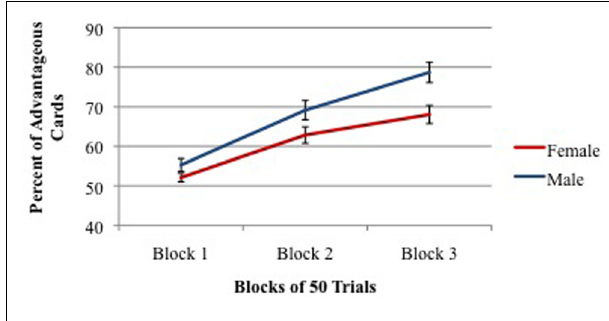
FIGURE 6 | Percent of advantageous card selections across three blocks of 50 trials for males (young + old) and females (young + old). Vertical bars indicate